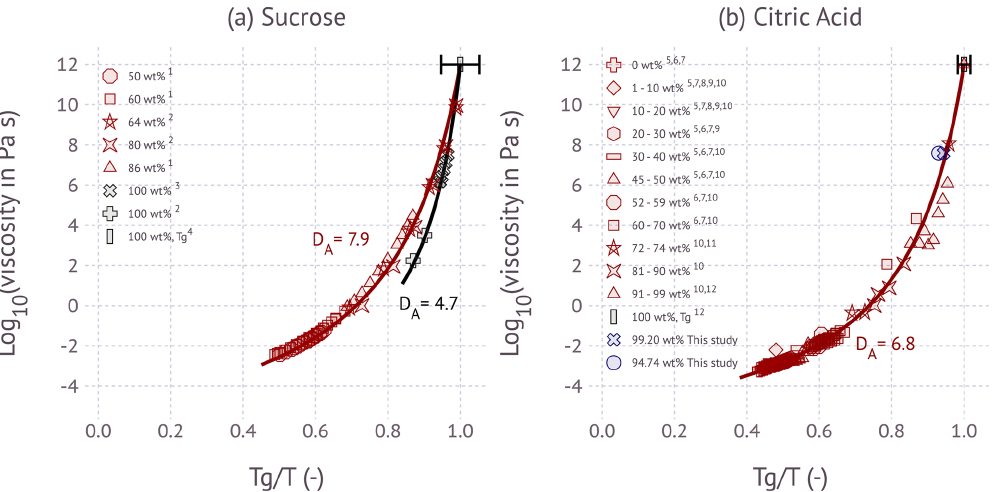
Figure 2. Angell representation of viscosity scaled by T g for the (a) sucrose–water system and (b) citric-acid–water system. Solid lines are fitted relations using the fragility parameterization. Black and red data points are from the literature: 1 Longinotti and Corti (2008), 2 Angell (2002), 3 Rothfuss and Petters (2017a), 4 Rothfuss and Petters (2017b), 5 Simion et al. (2014), 6 Laguerie et al. (1976), 7 Apelblat (2014), 8 Omran et al. (2019), 9 Haynes and Lide (2011), 10 Song et al. (2016), 11 Maltini and Anese (1995), and 12 Marsh et al. (2018). Red colors correspond to aqueous solutions with 0wt%–90wt% (weight percent) of solute, and black colors correspond to 90wt%–100wt% of solute. Blue colors represent results from this study. The error bar on T g corresponds to ± 18 and ± 5K uncertainty for sucrose and citric acid,